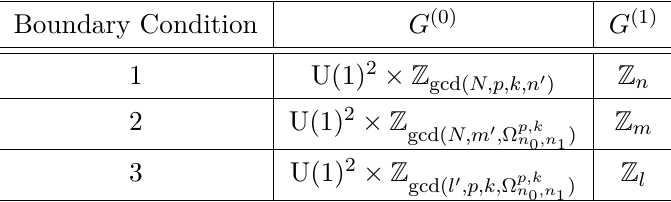
Table 2 . 0- and 1-form symmetries for the boundary conditions in table